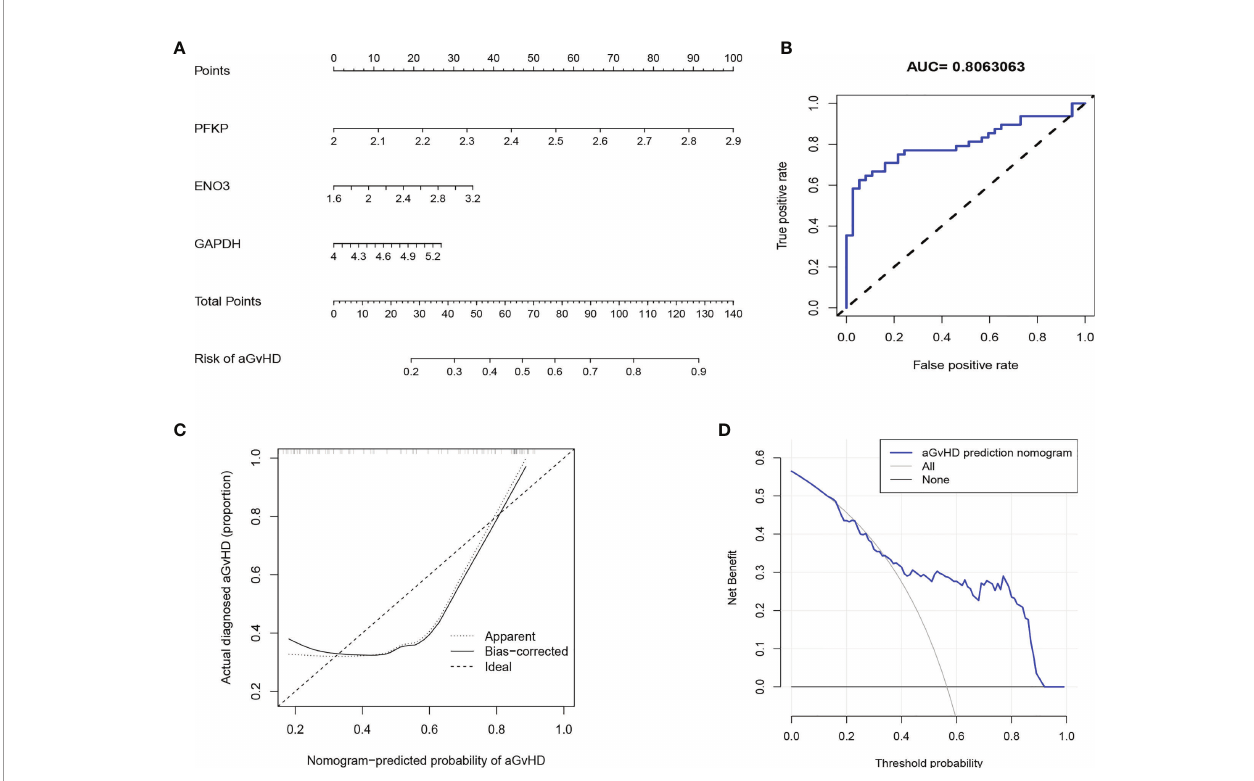
FIGURE 5 | Development of an individualized predictive model for acute graft-versus-host disease (aGvHD) with logistic regression. (A) Nomogram of aGvHD prediction. The aGvHD nomogram consists of three glycolytic genes, namely, PFKP , ENO3 , and GAPDH . (B) Receiver operating characteristic (ROC) curve shows the predictive value of the risk model. (C) Calibration curves of the aGvHD risk model. The x-axis represents the predicted aGvHD risk. The y-axis represents the actual diagnosed aGvHD. The diagonal dotted line represents the ideal predictive model. The solid line represents the performance of our risk model, of which a closer fi t to the diagonal represents a better prediction. (D) Decision curve for the aGvHD risk model. The y-axis measures the net bene fi t. The blue line indicates the aGvHD risk model. The thin solid line represents the assumption that all patients develop aGvHD. The thick solid line represents the assumption that no patient develops